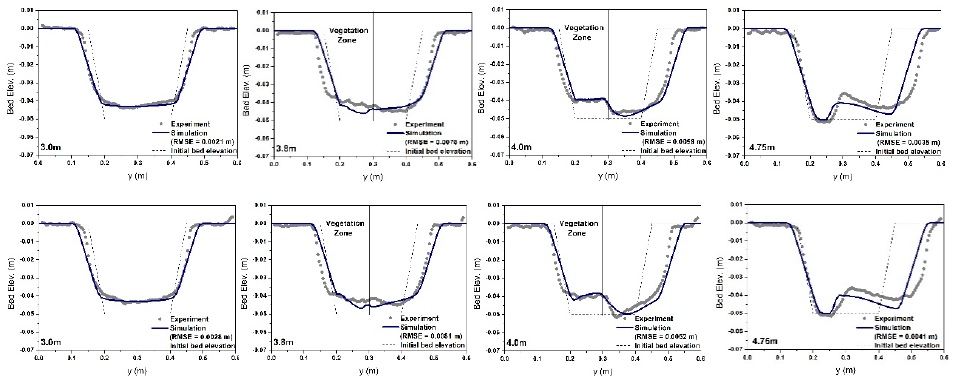
Figure 7. Comparison of bed elevation between experiment and computation for low density ( upper ) and high density ( lower ) of case 2.